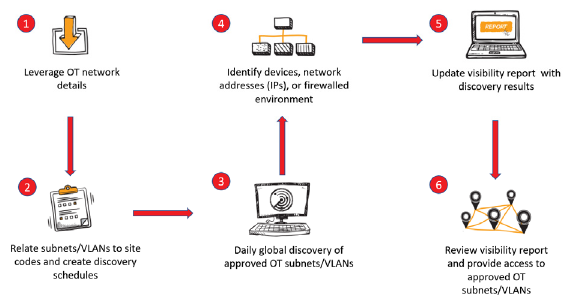
Figure 11. Device discovery technique in a firewalled environment